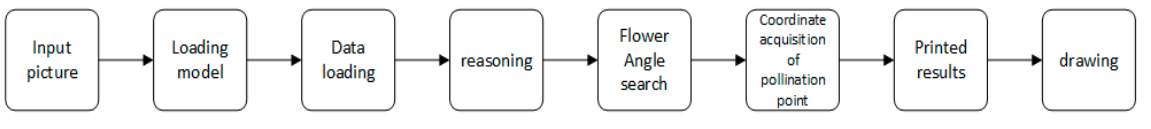
Figure 8. Image-reasoning process diagram.